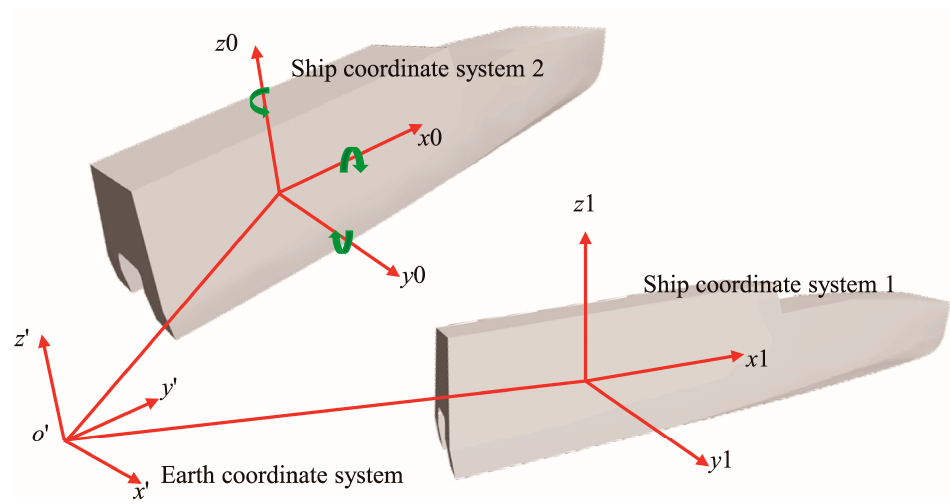
Figure 2. Hull coordinate system and earth coordinate system.